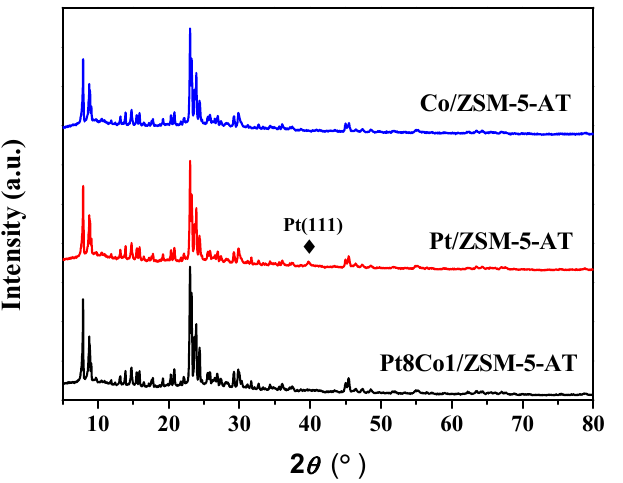
Figure 1. XRD patterns of the as-prepared Pt/ZSM-5-AT, Co/ZSM-5-AT and Pt8Co1/ZSM-5-AT catalysts. Next, the location of metal particles in the spent catalysts was also examined by TEM method. Figure 2 displayed the TEM images of these ZSM-5-AT-supported metal catalysts. As seen from Figure 2a,b, the PtCo nanoparticles on the ZSM-5-AT support display an average size of 4–5 nm measured from randomly counting 100 particles and the bimetallic PtCo nanoparticles were highly dispersed on the surface of ZSM-5-AT support. Compared with the as-prepared Pt8Co1/ZSM-5-AT catalysts (Figure 2c), the relative bigger Pt particles with size of 6–7 nm were found for Pt/ZSM-5-AT catalyst, demonstrating that the existence of Co was favorable for the distribution of metallic Pt particles. The small size and high uniformity of the PtCo bimetallic nanoparticles in Pt8Co1/ZSM-5-AT would be beneficial to offer more active reaction sites and enhance the catalytic activity. In addition, as shown in Figure 2d, no Co nanoparticles were observed in Co/ZSM-5-AT catalysts. These results were also consistent with the XRD